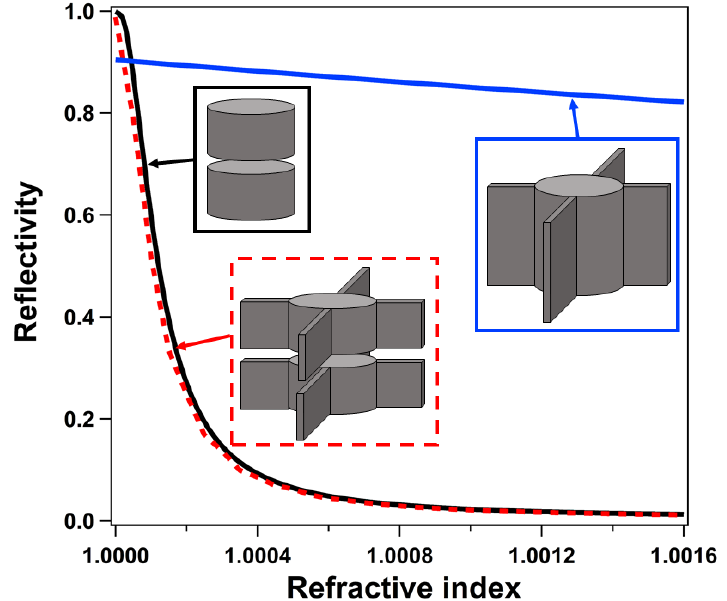
Figure 4. Intensity-based sensitivity. Reflectivity as a function of the refractive index of the environ- ment at the resonant wavelength (obtained at n env = 1). The insets compare the unit cells of the three different metasurfaces to highlight the key role of the small gap between the disks: (Black) Periodic double disk arrays without spokes at λ res = 1382 nm. (Red) Periodic double disk arrays with 20 nm spokes at λ res = 1382 nm. The cylinder height is 274 nm, and the gap is 15 nm. (Blue) Periodic single disk array with 20 nm spokes and height of 563 nm at λ res = 1410 nm. The radius and periodicity are set to 250 and 850 nm,